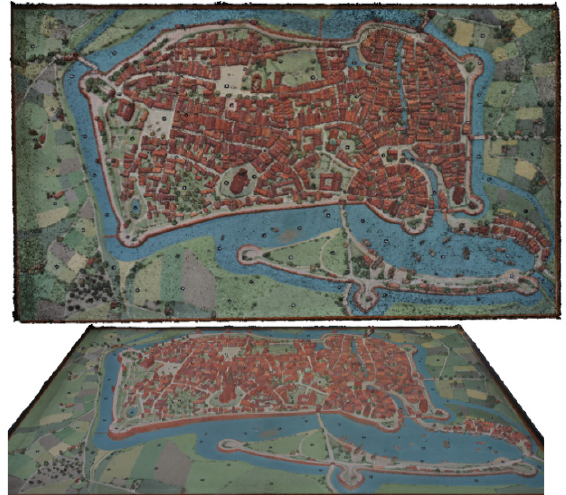
Figure 4. Top: 3D dense point cloud of the physical city model of Stade in the year 1620; Bottom: Perspective view of textured 3D meshed